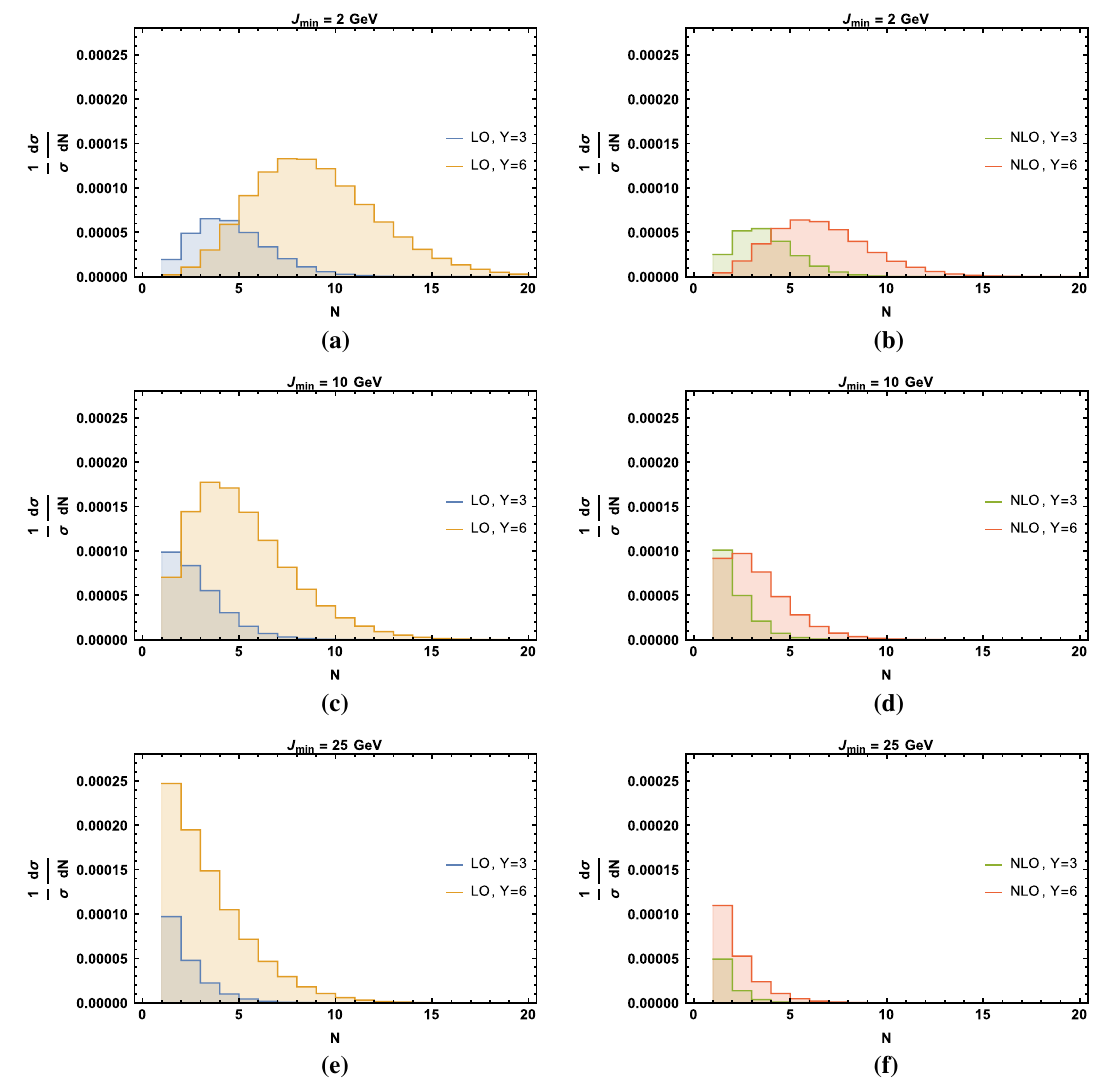
Fig. 1 Multiplicity distributions for Y = 3 , 6 and J min = 2 , 10 and 25 GeV (top, middle,